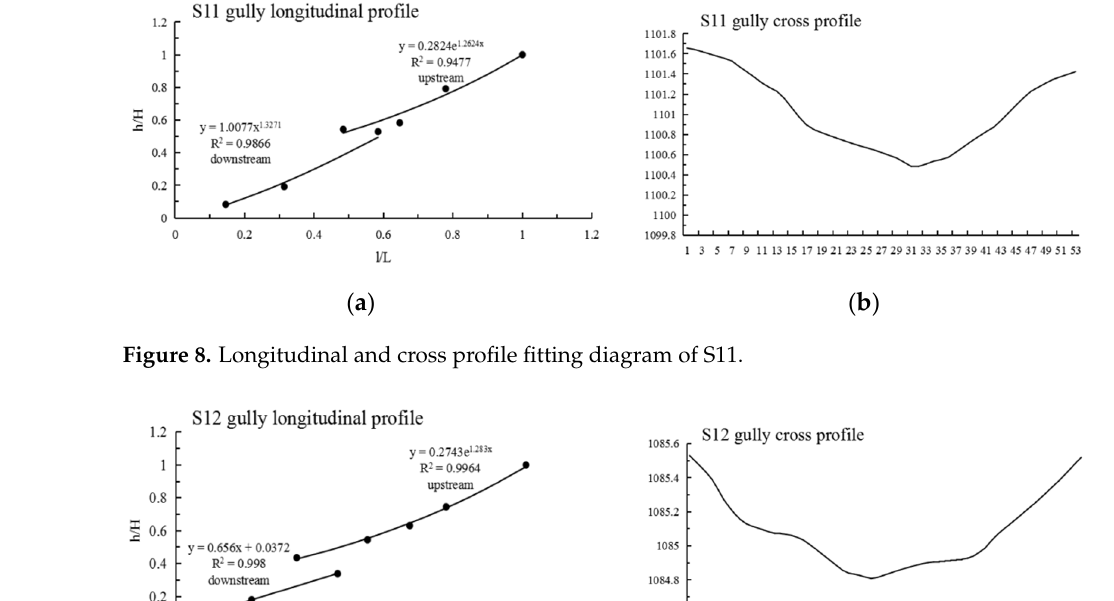
Figure 7. Longitudinal and cross profile fitting diagram of S6.